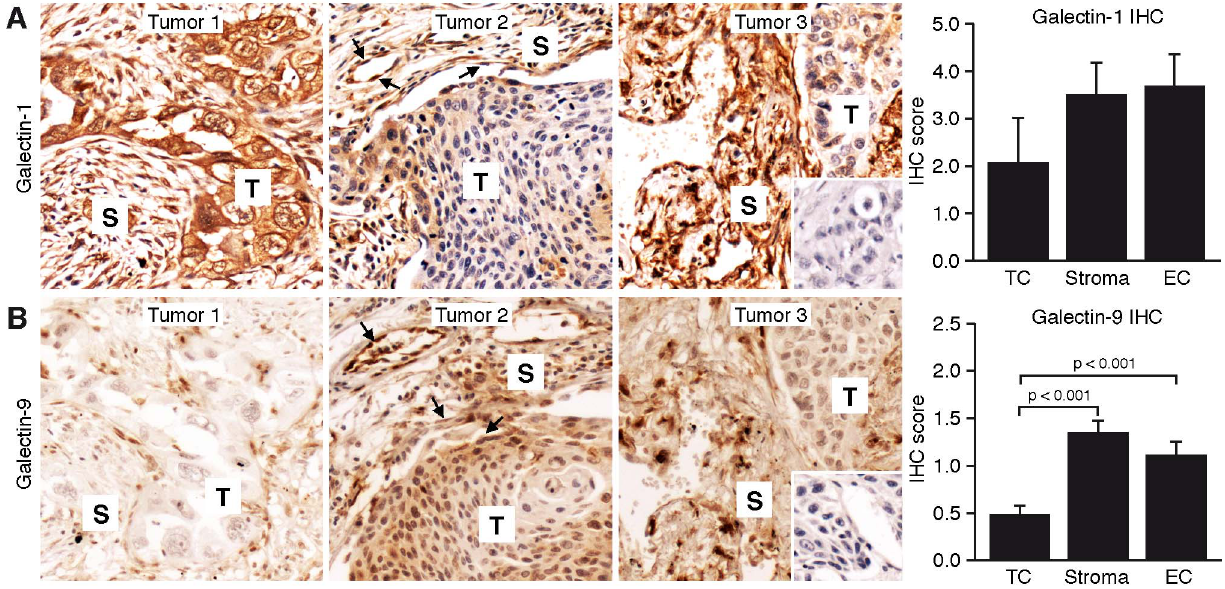
Figure 3. Images of immunohistochemical galectin-1 stainings (A: brown) and galectin-9 stainings (B: brown) of three representative tumors. Staining was observed in tumor cell compartment (T), stromal compartment (S) and in tumor endothelial cells (arrows). The inset on the left shows the isotype control staining. Scale bar=50 micrometer. The bar graphs showing quantification of IHC scores for galectin-1 and galectin-9 in different tumor